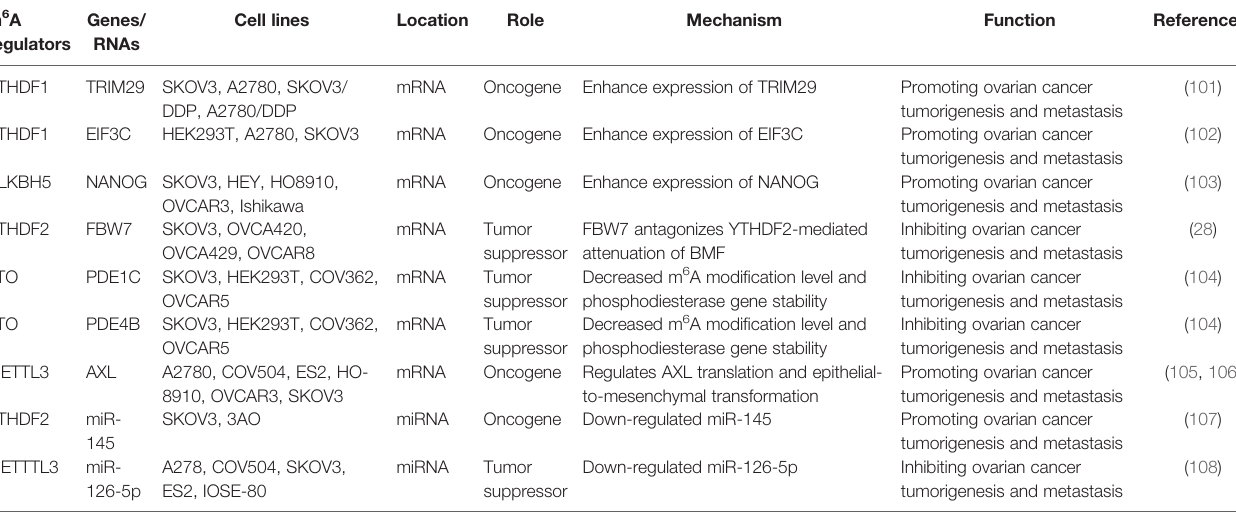
TABLE 3 | The roles of different m 6 A regulators in regulating RNAs in ovarian cancer. m 6